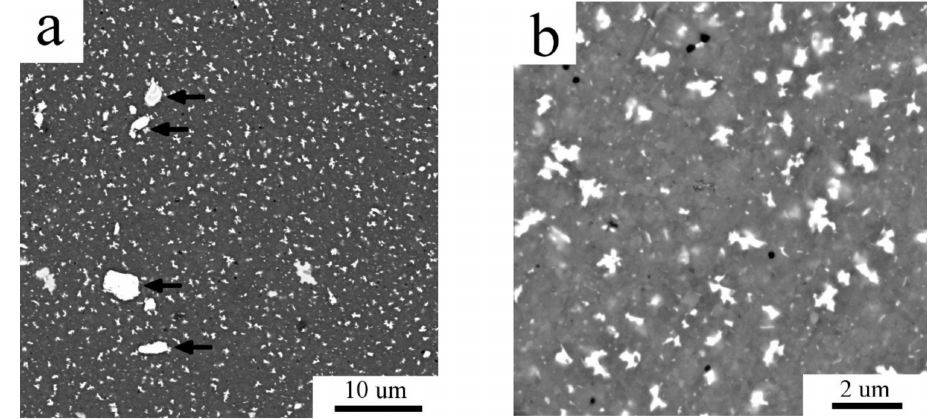
Figure 7. The microstructure of the Al7075_MC compact. ( a ) BSE contrast image; ( b ) detail of the BSE contrast image,